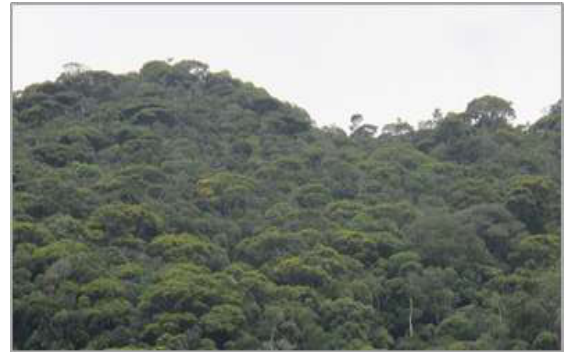
Figure 6. Types of vegetation – Advanced Internship in Forest Conservation.